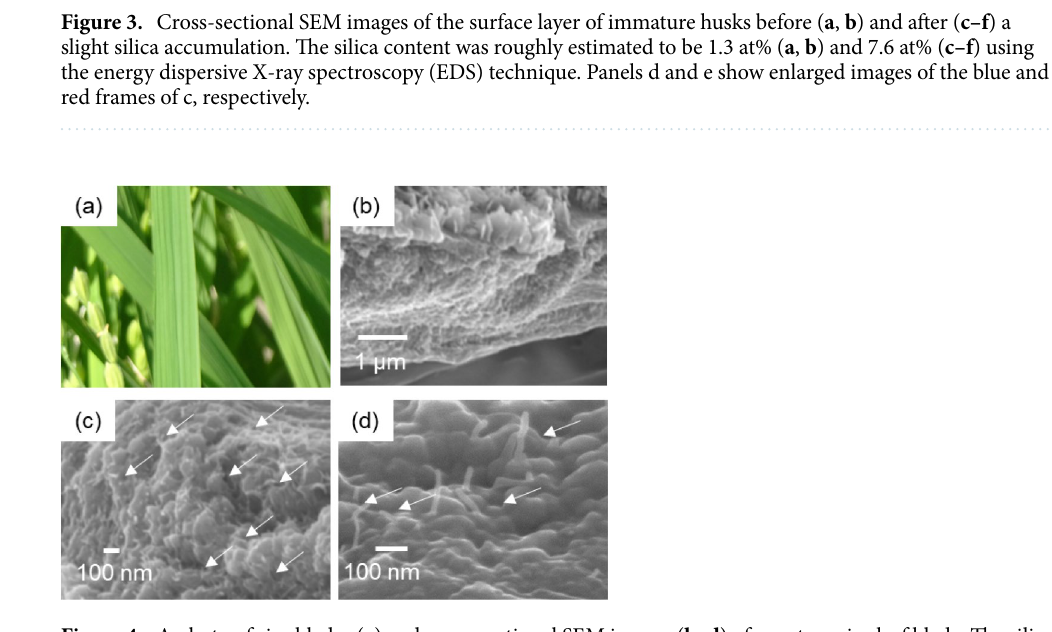
Figure 4. A photo of rice blades ( a ) and cross-sectional SEM images ( b–d ) of a mature rice leaf blade. The silica plate shown in panels b and c was freeze-dried and then fractured with a scalpel. White arrows indicate thin fibrils ( c , d ).